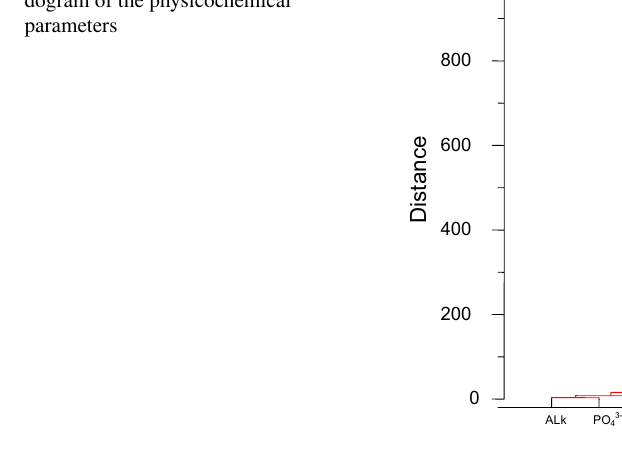
Fig. 8 Hierarchical cluster den- dogram of the physicochemical